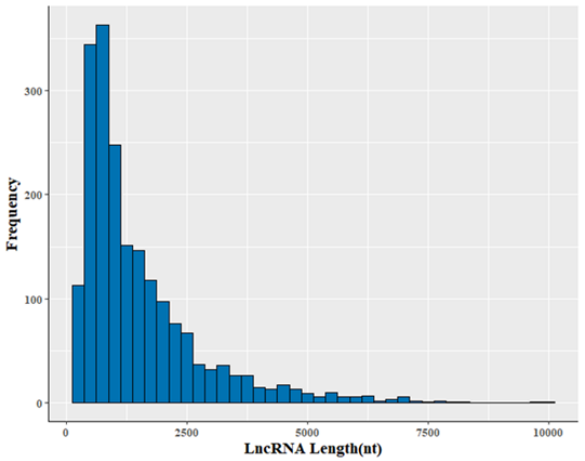
Figure 2. Profile of lncRNA lengths.